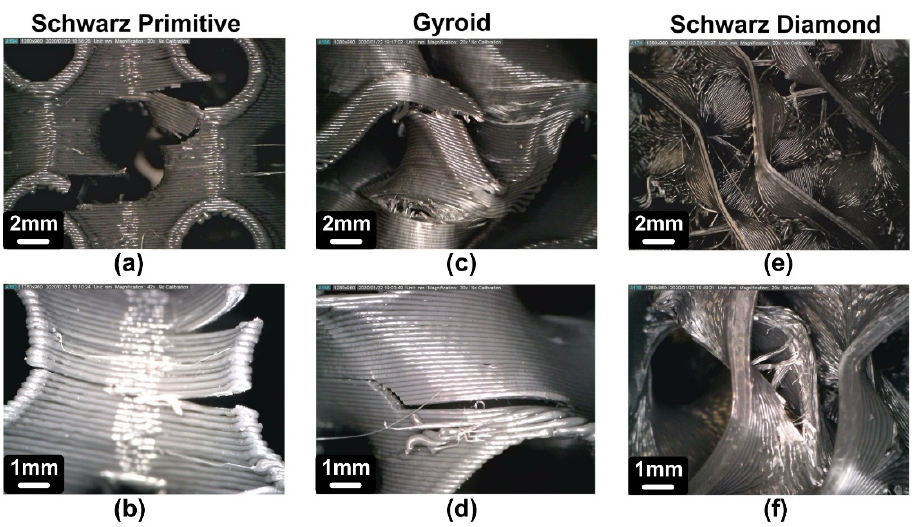
Figure 6. Fracture areas at 15% strain for ( a , b ) Schwarz Primitive, ( c , d ) Gyroid and ( e , f ) Schwarz Diamond TPMS